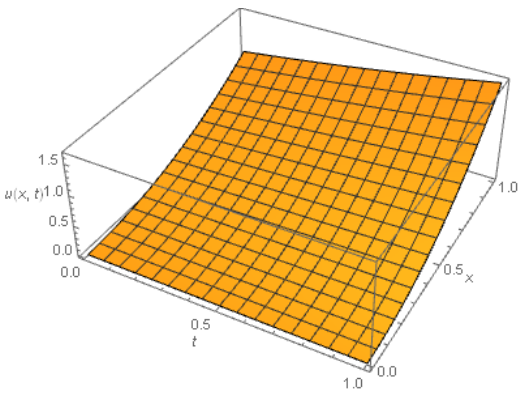
Figure 2:3D approximate Solution of example1 with (cid:11) = 1